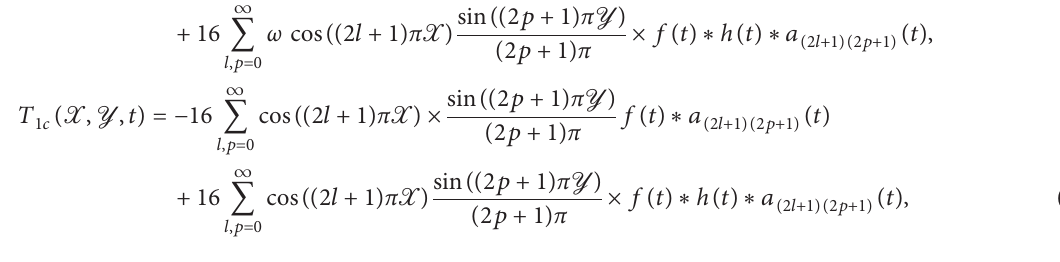
λ 2=0.3 for both the oscillations with ω � π /4, λ 2